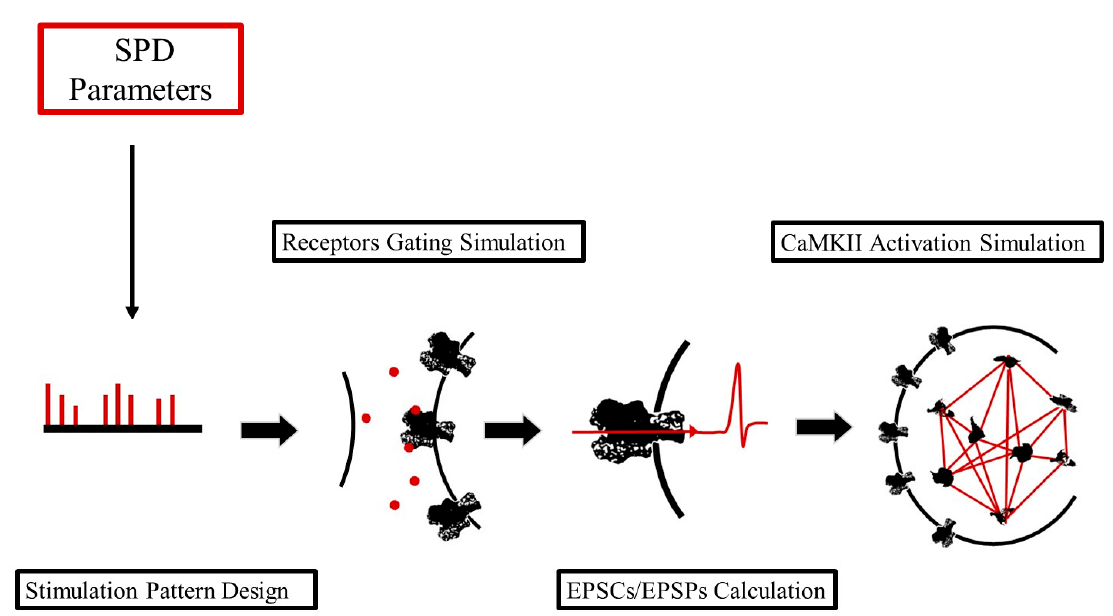
Figure 1. Conceptual scheme of the pipeline to simulate our synaptic transmission model. This scheme illustrates all of the four modules of our framework: (i) Stimulation Pattern Design (SPD module); (ii) Receptors Gating Simulation (RGS module); (iii) Excitatory Post-Synaptic Currents and Potentials (EPSCs/EPSPs) Calculation (CPC module); (iv) Ca 2+ /Calmodulin-dependent Kinase II (CaMKII) Activation Simulation (CAS module).